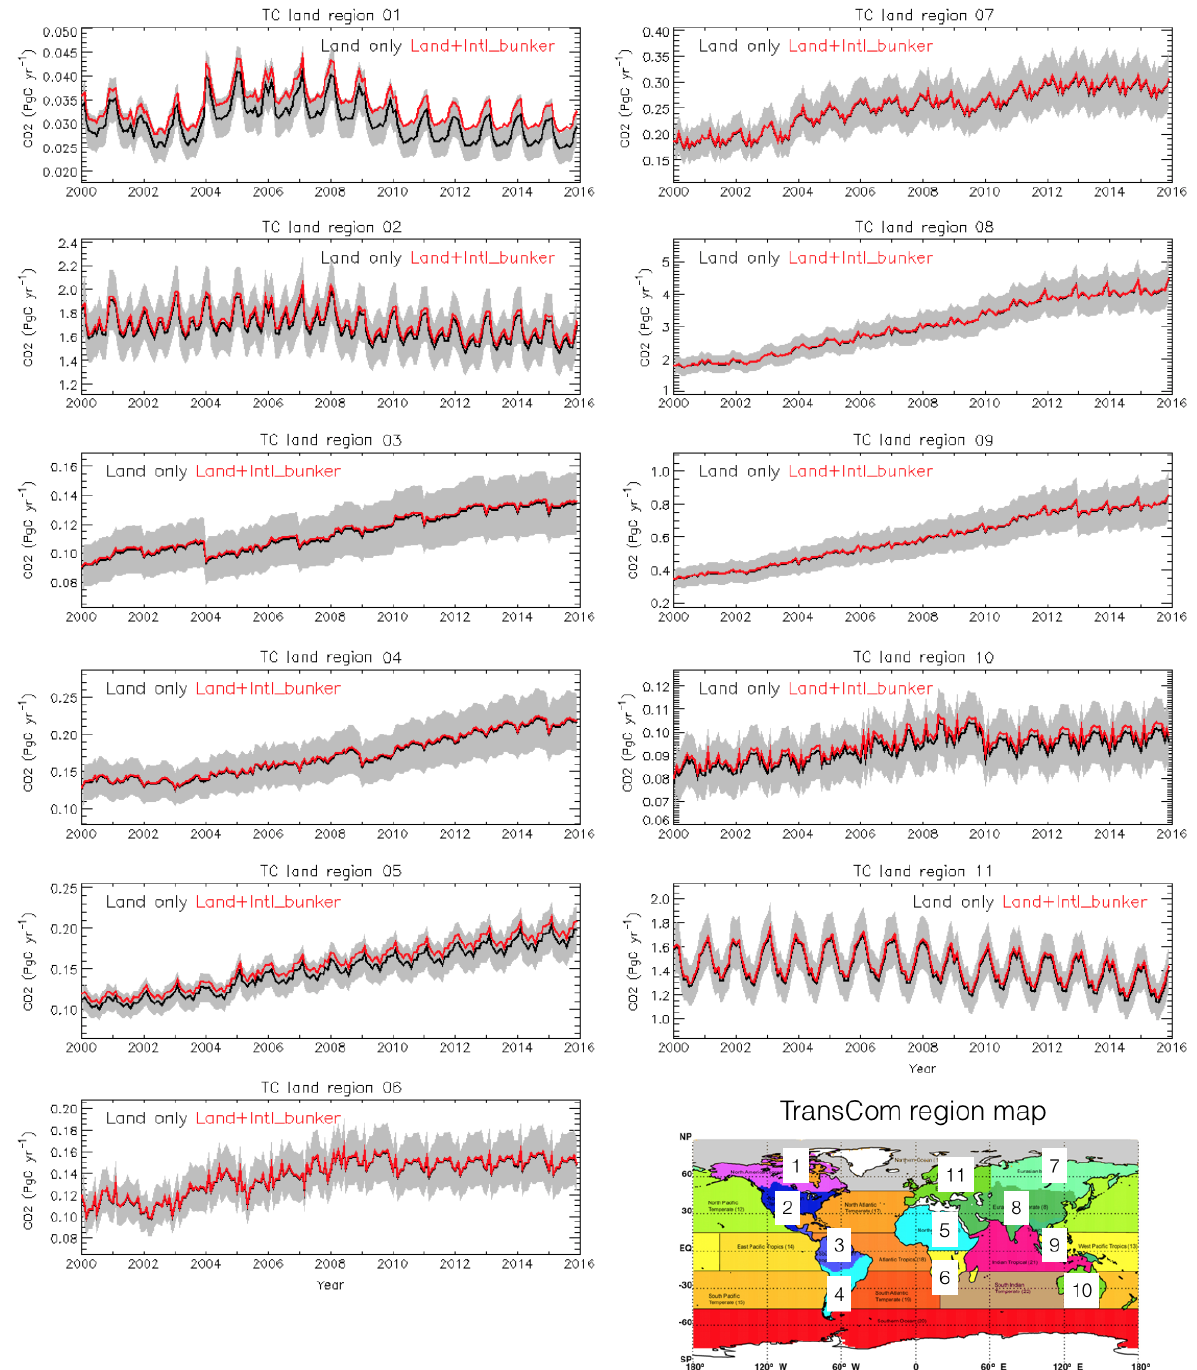
Figure 8. Emissions time series over inversion analysis land regions defined by the Transport Model Intercomparison Project (TransCom) (Gurney et al., 2002). The TransCom region map (bottom right) is available from http://transcom.project.asu.edu/transcom03_protocol_ basisMap.php (last access: 8 November 2016). Black lines indicate the ODIAC 1 × 1 ◦ monthly emissions. The monthly emissions are calculated using the 1 × 1 ◦ ODIAC emissions data. The uncertainty range was calculated using mass weighted uncertainty estimates of countries that fall into the regions (see Table 3). The uncertainty ranges shown in this figure are annual uncertainty plus the monthly profile uncertainty (12.8%; reported by Andres et al., 2011). Note that scales on the vertical axis are different.